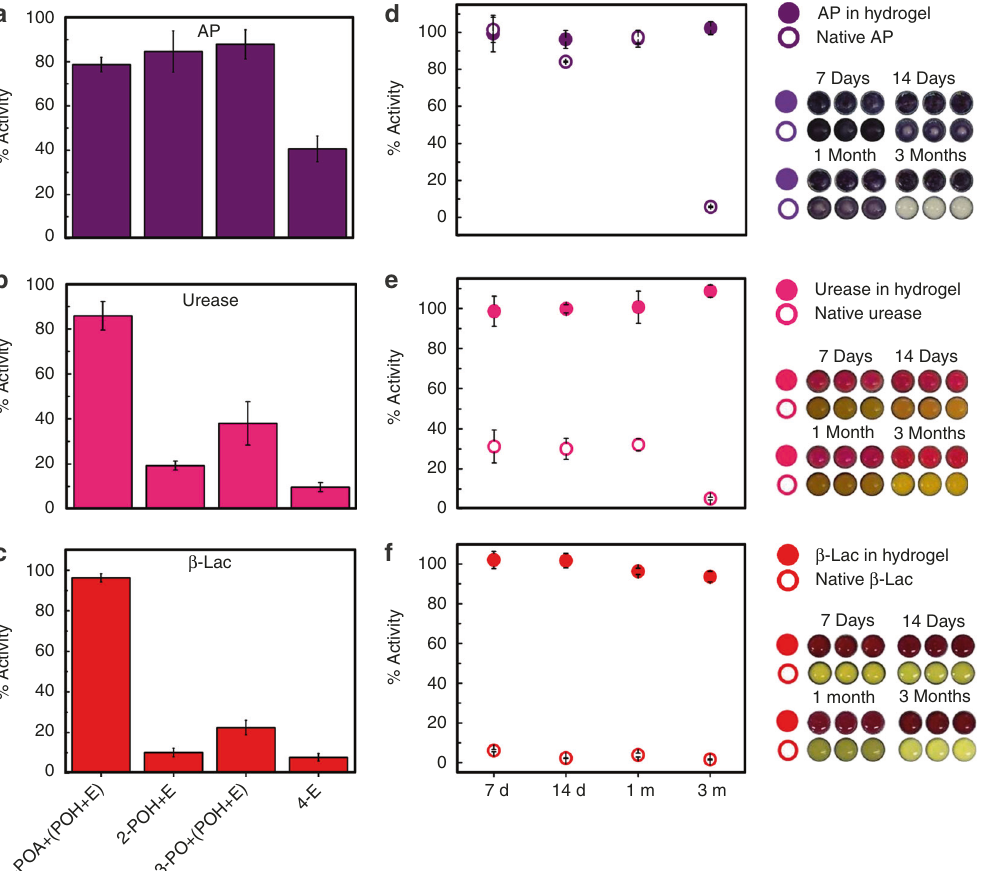
Fig. 3 Printed hydrogels can stabilize enzymes. Remaining activity of enzymes (E) was quanti fi ed ( a – c ) after 2 h of protease treatment with proteinase K (a protease that hydrolyzes peptide bonds and thus deactivates enzymes) or ( d – f ) following dry storage at room temperature for varying periods of time. The residual activity after each treatment was normalized relative to the initial activity of a freshly printed sample. The hydrogel protects the enzymes against proteolytic degradation by proteinase K and supports enzyme stabilization for long-term storage. ( a , d ) Alkaline phosphatase; ( b , e ) urease; ( c , f ) β - lactamase. Data are presented as means ± SDs ( n =